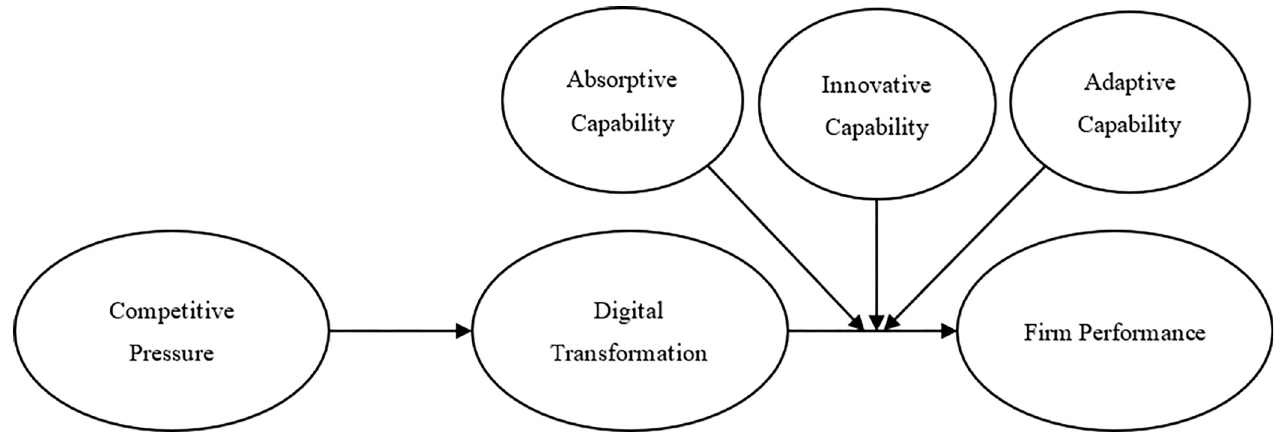
Fig 2. The research model in Study